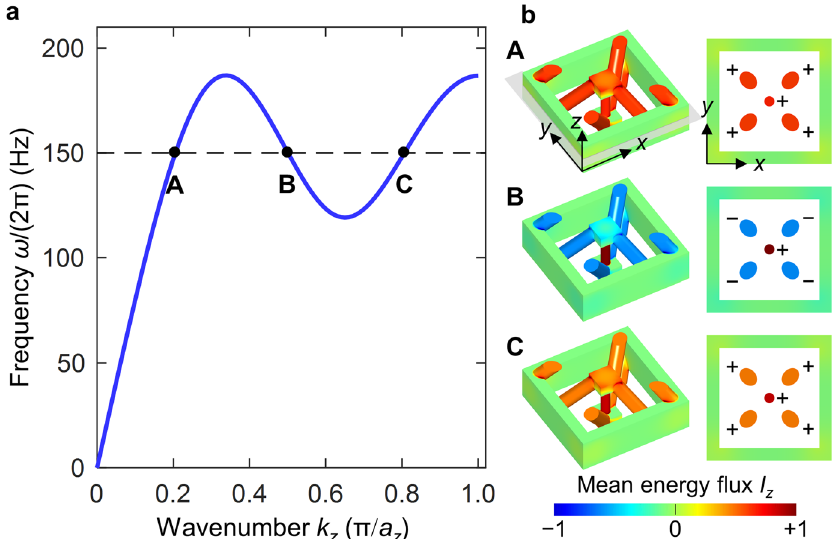
Fig. 6 Roton-like behavior for airborne sound. We consider a structure which is the complement of the one shown in Fig. 3. This leads to a network of channels inside a rigid material in which air can fl ow. a Acoustical dispersion relation ω k z z -direction, exhibiting a roton-like minimum within the fi rst Brillouin zone k energy fl ux I z on a false-color scale along the z -direction for the three eigenmodes A , B , and C marked in a at the same frequency of 150 Hz. As in Fig. 4b, backward-wave behavior is observed for mode B , for which the group velocity is negative. The lattice constant is chosen as a z ¼ 10 cm. All other parameter ratios are the same as in Fig. 3. We assume ambient conditions, corresponding to an airborne speed of sound of v air ¼ 340 m = s and a mass density of ρ ¼ 1 : 29 kgm (cid:2) 3 air